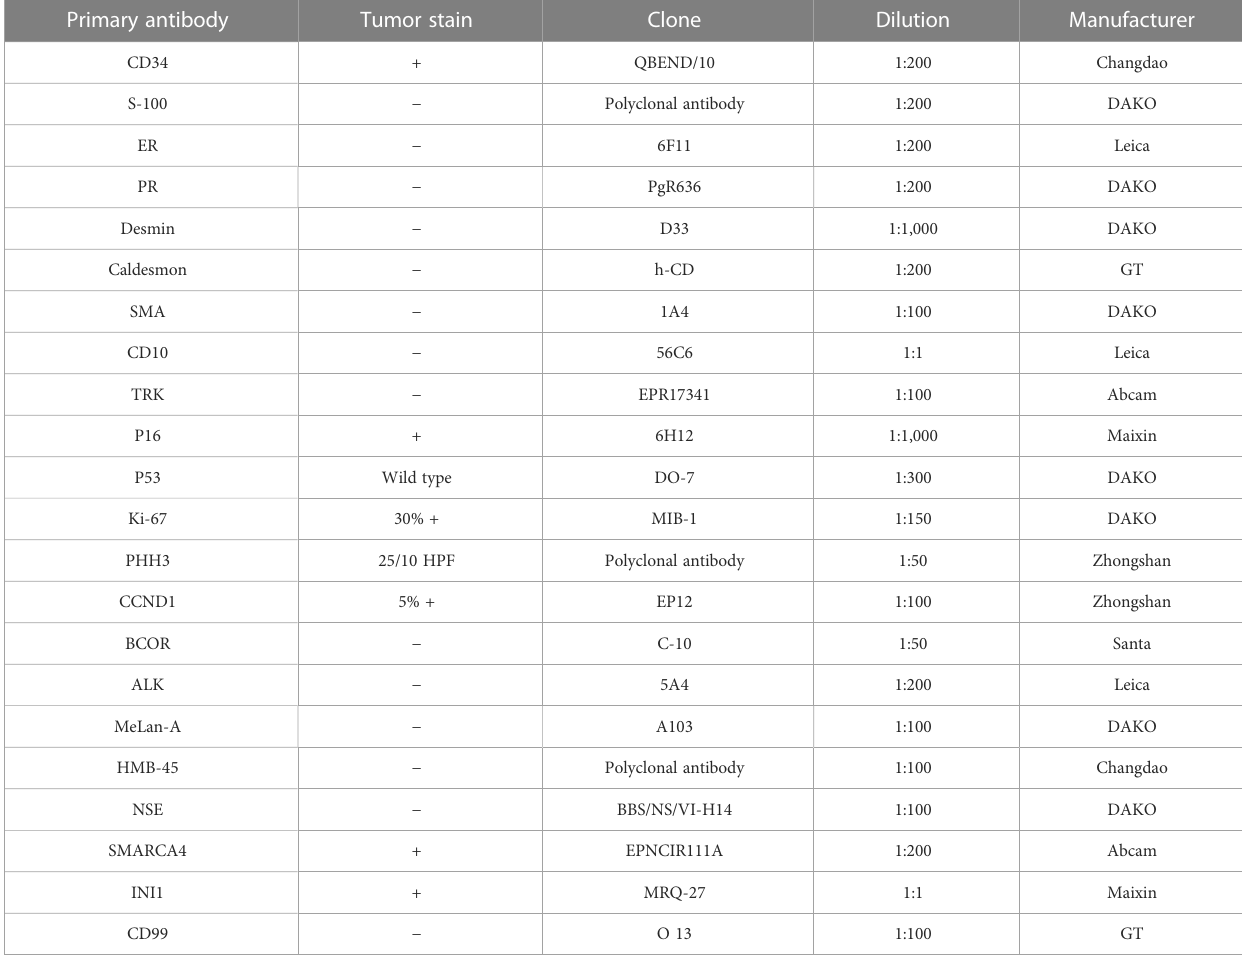
TABLE 1 Details of immunohistochemical results in this case presentation. Primary